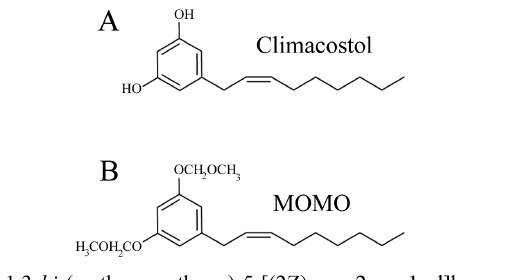
Figure 8. Molecular structures of ( A ) climacostol, and ( B ) MOMO.